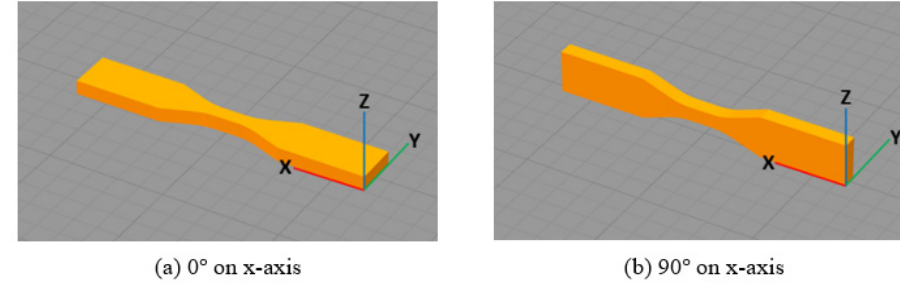
Figure 3. Illustration of the build orientation for the experiments. ( a ) 0° on x-axis; ( b ) 90° on x-axis.